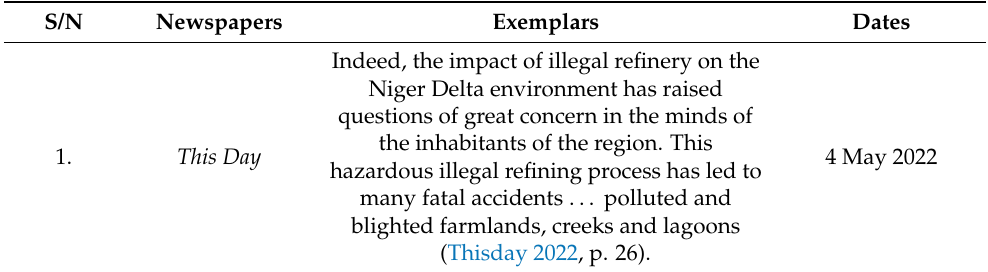
Table 5. Reporting on Psychological